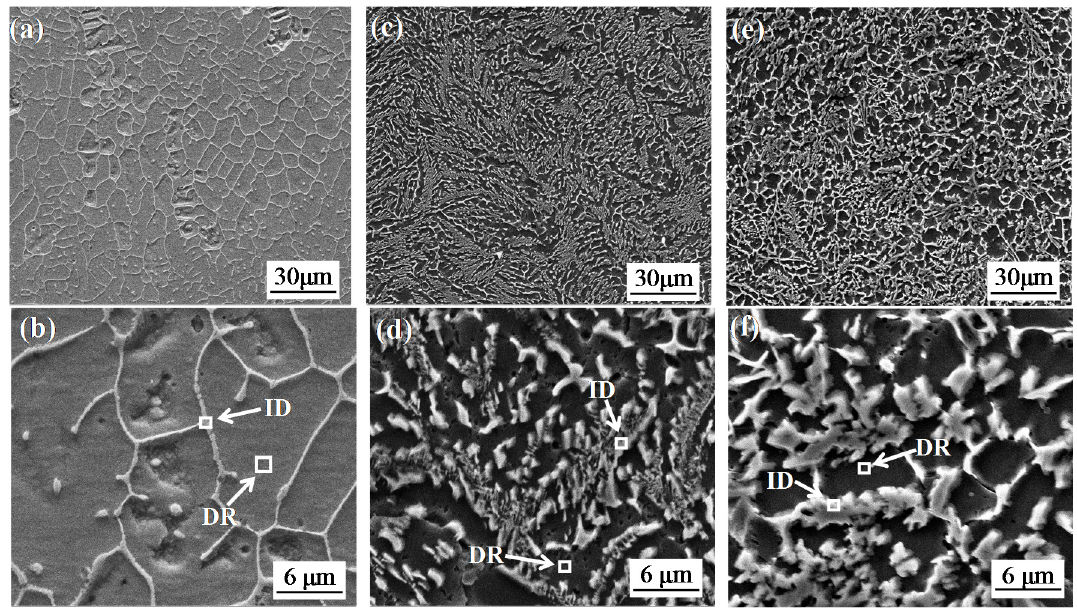
Figure 3. The dendritic (DR) and interdendritic (ID) microstructure in the Al 2.3 B y HEA coatings: ( a , b ) Al 2.3 B 0.15 coating; ( c , d ) Al 2.3 B 0.3 coating; ( e , f ) Al 2.3 B 0.6 coating.